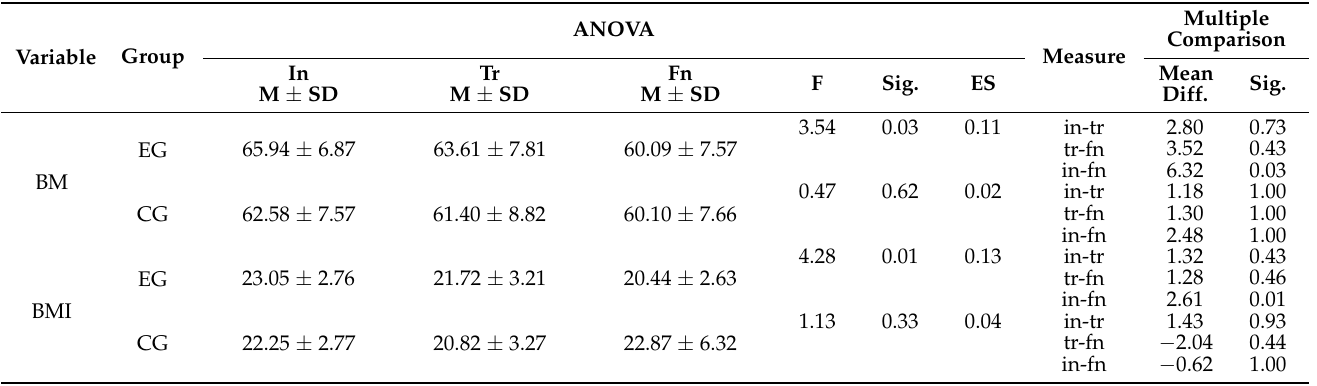
Table 3. Difference between measurements (initial, transit, and final) within groups (EG and CG) for body